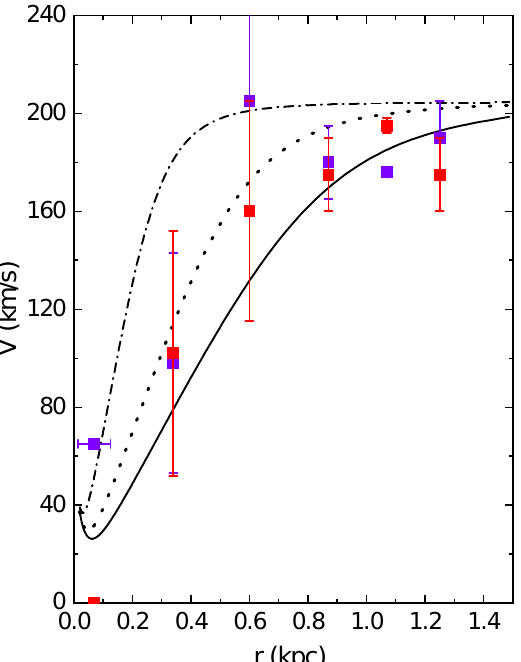
Figure 1. The rotation curve of the mini-disk of galaxy NGC 4736. The observational data are based on the rotational lines of CO (J = 1-0 transition: red, and J = 2-1 transition: purple squares) taken from [18]. Solid, dotted, and dash-dotted lines are the rotation curves adopted in this